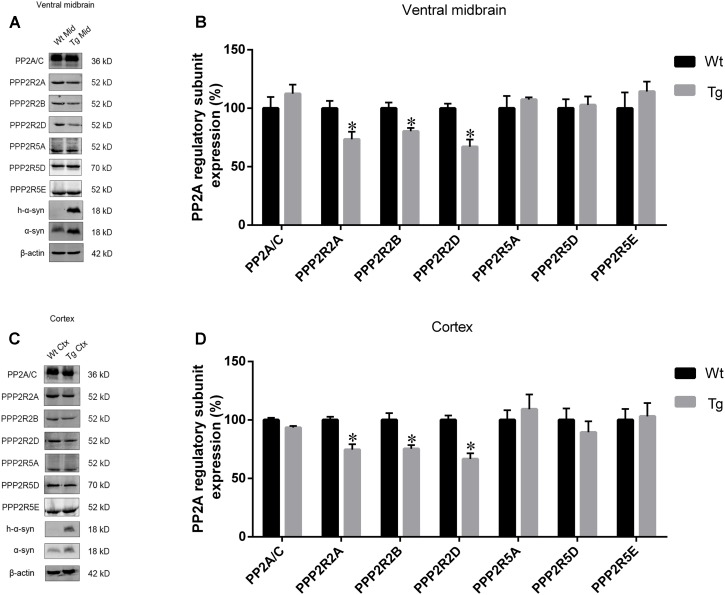
The expression of regulatory subunits which belong to the PPP2R2 subfamily, not PPP2R5 subfamily, were downregulated in examined brain regions of Tg mice. (A,C) western blot results for PP2A subunit expression from brain homogenates of ventral midbrain as well as cortex of Tg mice and Wt littermates. β-actin was used as a loading control. (B,D) quantitative analysis of western blot data. The ratio of individual PP2A subunit expression to β-actin in Wt group was considered as 100%. Data are expressed as mean ± SD. KS test; P > 0.05; F-test; P > 0.05; unpaired Student’s t-test; ∗P < 0.05 vs. Wt littermates (n = 3).